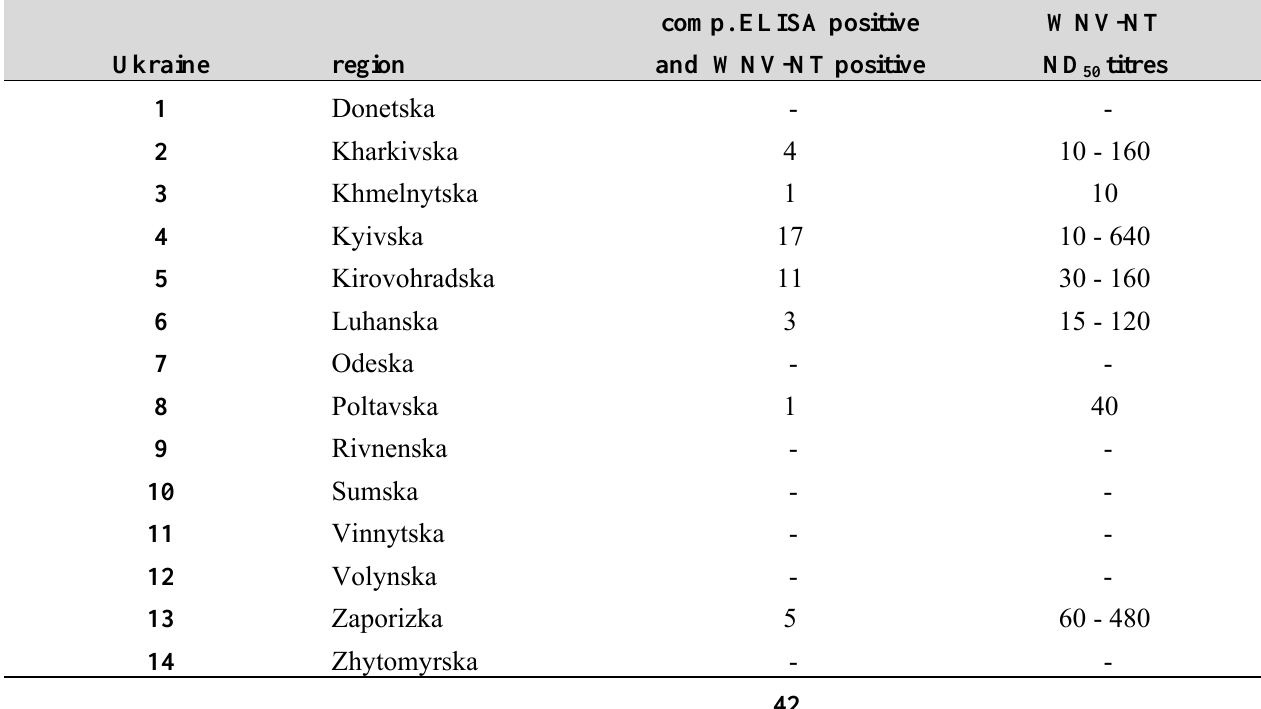
Table 4. Distribution of the ELISA and NT positive